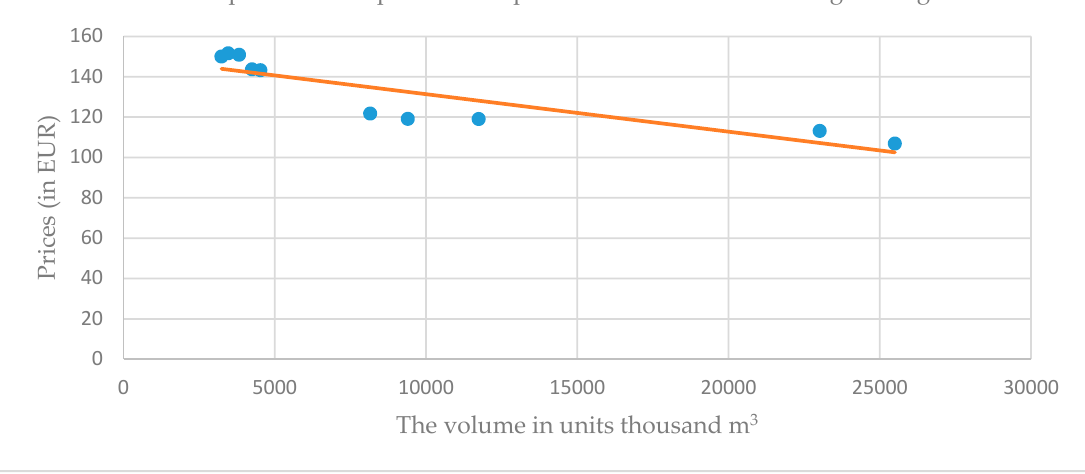
Figure 3. The dependence of the price of spruce wood on the volume of random logging—linear regression model. Source: own calculations; linear regression model: y − 0.0469x + 3779.2; R ² = 0.8145.